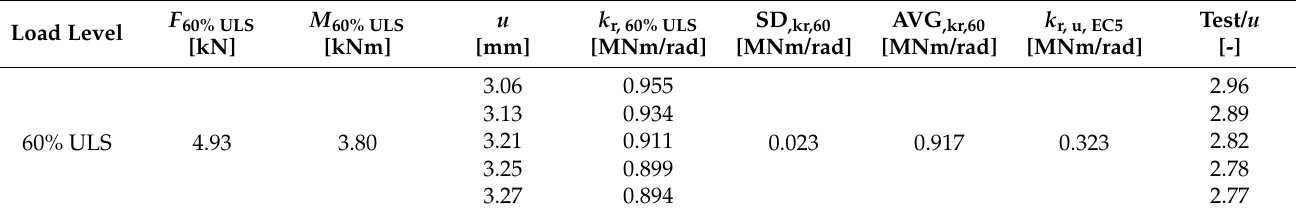
Table 6. Results of quasi-static cyclic testing for Experiment A at 60% ULS.